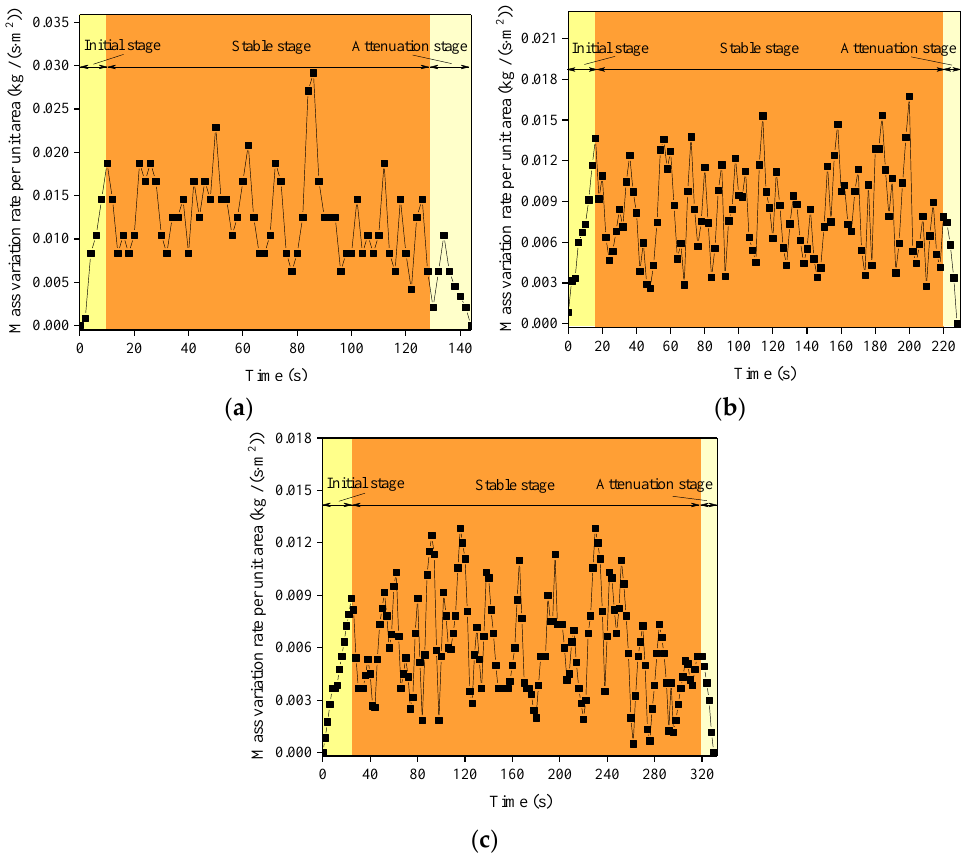
Figure 4. Mass variation rate per unit area of gasoline during the burning process. ( a ) Chengdu, Sichuan; ( b ) Kunming, Yunnan; ( c ) Lhasa, Tibet.